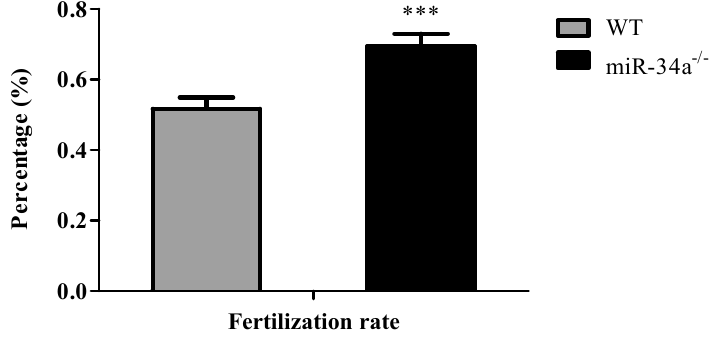
Figure 5. Fertilization rates of WT and miR-34a − / − male zebrafish when they mated with WT female zebrafish. *** p < 0.001.